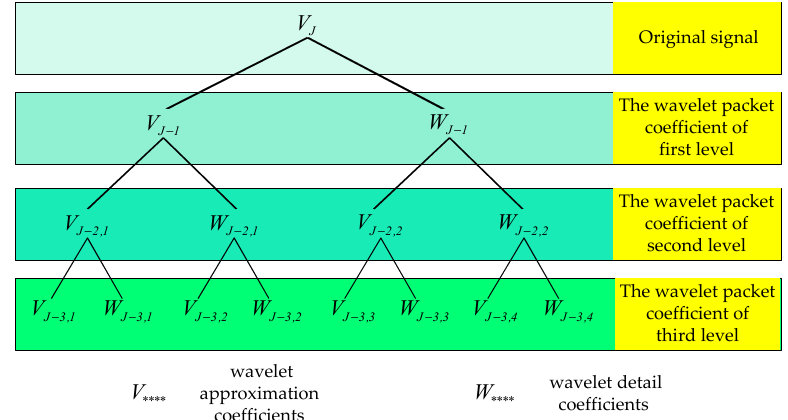
Figure 2. Decomposition process of wavelet packet decomposition (three levels as an example).